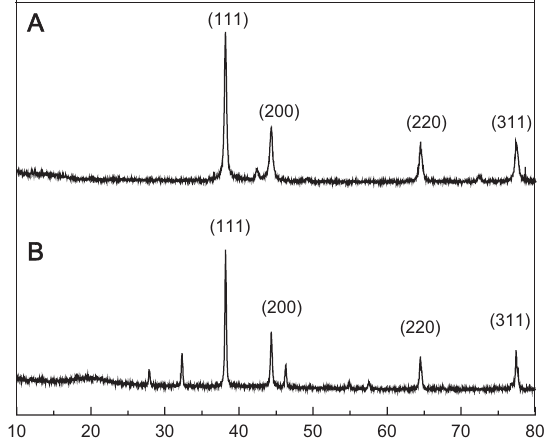
Figure 2 XRD of: (A) the inorganic powder generated by ther- mal decomposition of pure Ag(acac), and (B) Ag/PS nanocom- posite obtained by thermally decomposing Ag(acac) dissolved in